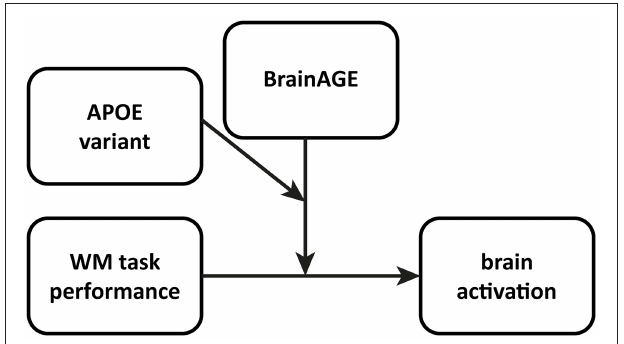
FIGURE 1 | Conceptual diagram of the multiple regression model employed to analyze interaction effects in fMRI data allowing for moderated moderation. WM performance is the “focal” predictor, whereas BrainAGE as well as APOE variant act as moderators. In this model, 2- as well as 3-way interactions are possible, so as the focal predictor and both moderators can interact with each other. See also model templates for PROCESS Macro, http://www.afhayes.